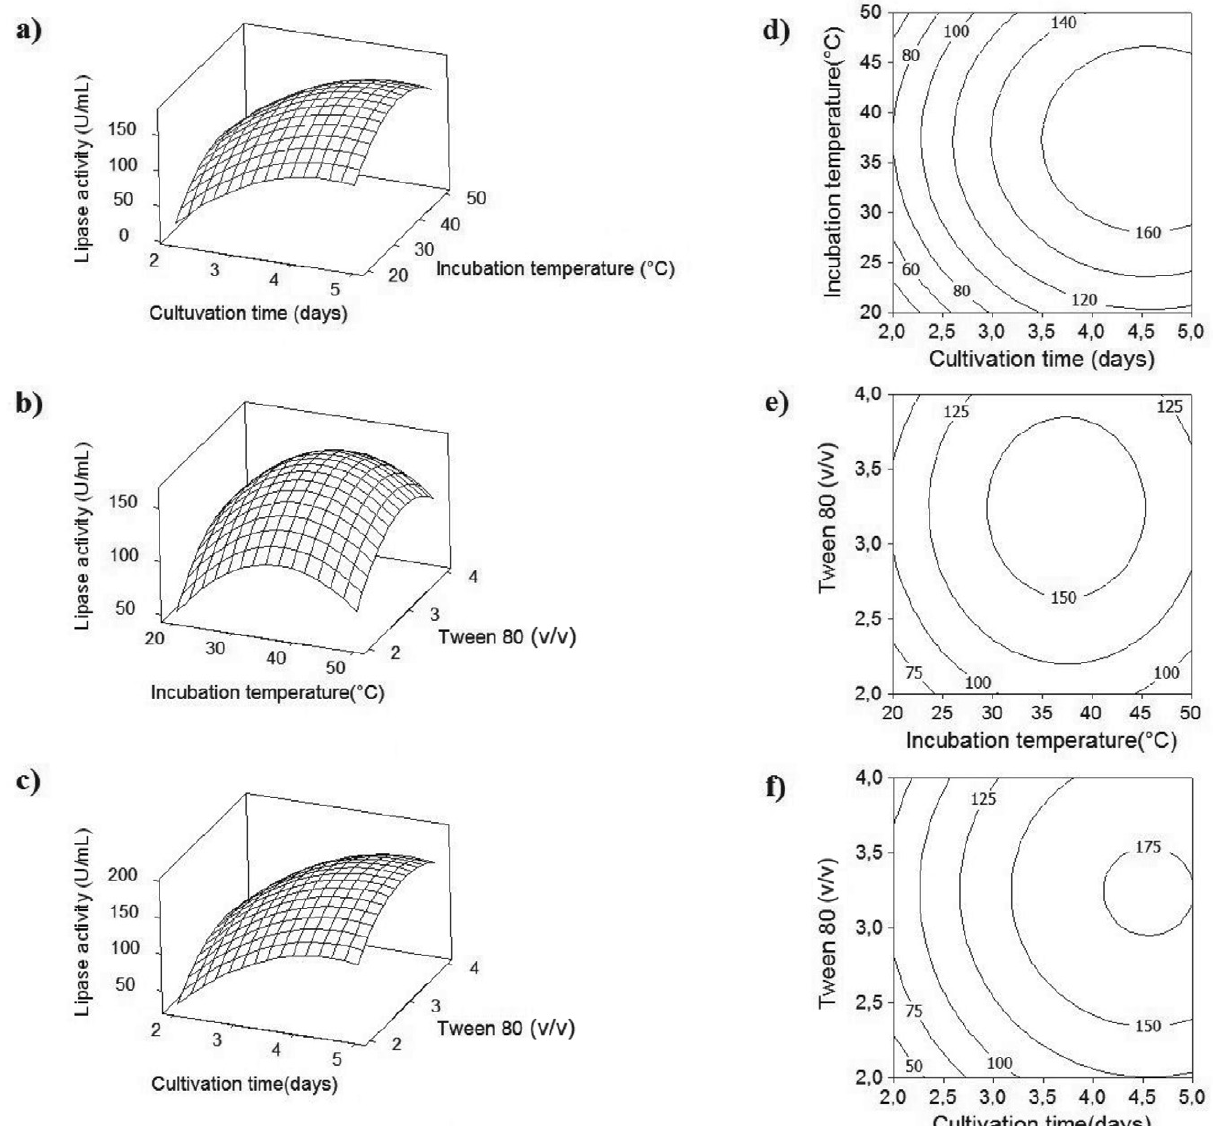
Figure 3 . Response surface graphs with contour plots for the effects of independent variables on lipase activity (U/mL), and their mutual interac- tions, respectively: incubation temperature and cultivation time (a) and (d), incubation temperature and Tween 80 (v/v) (b) and (e), cultivation time and Tween 80 (v/v) (c) and